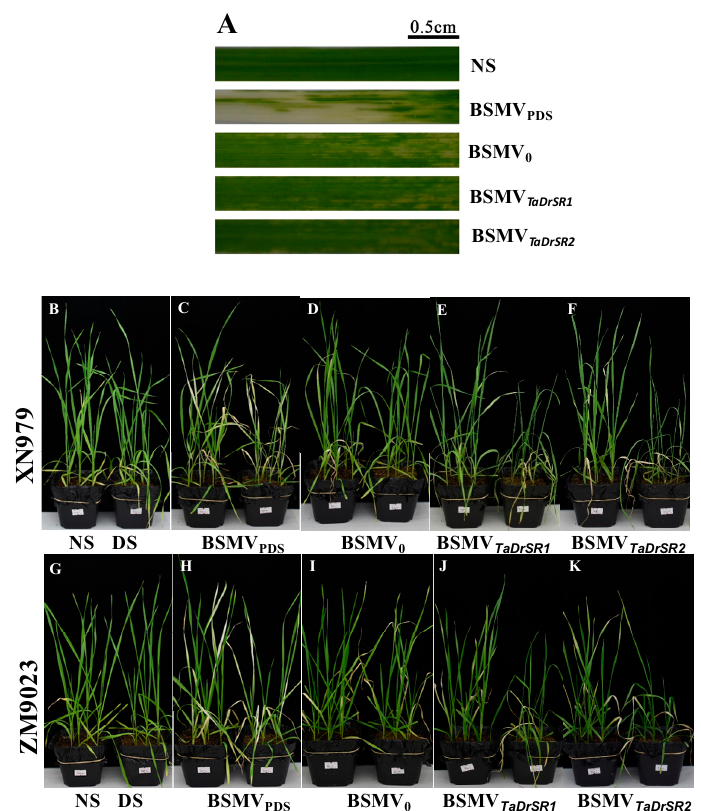
Figure 5. The phenotypes of TaDrSR1- and TaDrSR2 -knock-down plants. ( A ) Leaf; ( B – K ) Whole plants; XN979 was selected as the receptor for viral infection in the VIGS experiment; ( G – K ) ZM9023 was selected as the receptor for viral infection in the VIGS experiment. The pot on the left side of each picture represents the no stress (NS) treatment and the pot on the right side represents the drought stress treatment (DS). BSMV 0 represents the negative control of VIGS system; BSMV PDS represents the positive control monitoring time course of VIGS; BSMV TaDrSR1 and BSMV TaDrSR2 represent TaDrSR1- and TaDrSR2 -knock-down plants, respectively.